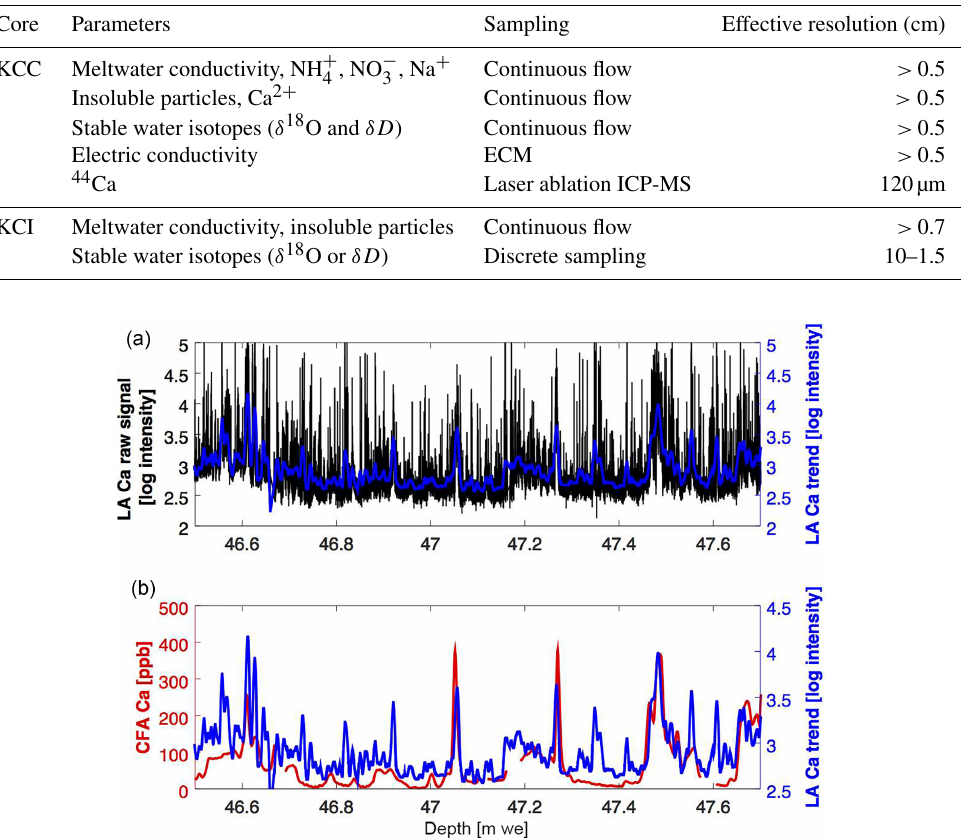
Figure 2. Ca signals obtained from the KCC ice core at around 65% relative depth using LA-ICP-MS and CFA in direct comparison after careful alignment of the two depth scales. (a) Raw (black) and filtered LA-ICP-MS Ca signal (blue). (b) CFA Ca (red) vs. filtered LA-ICP- MS Ca signal (blue). Note (i) the additional peaks and high-frequency information revealed by LA-ICP-MS, (ii) a general agreement of CFA and low-frequency LA-ICP-MS components consistently observed over core parts measured by LA-ICP-MS. LA-ICP-MS intensity is reported as counts per